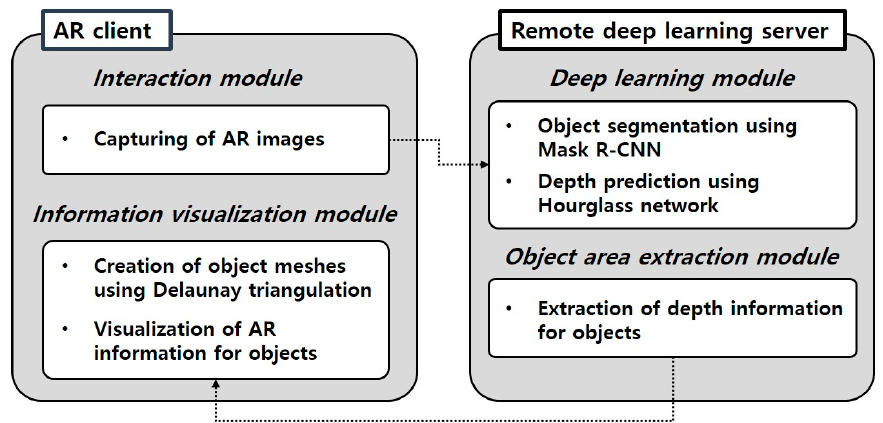
Figure 4. AR client and remote deep learning server.